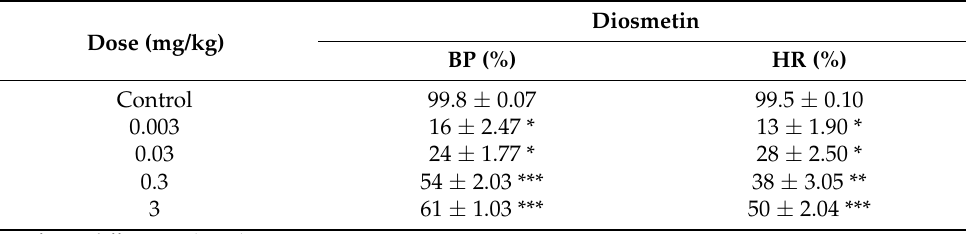
Table 1. The percentage decrease in the BP and HR of anesthetized rats after the injection of different doses of diosmetin.